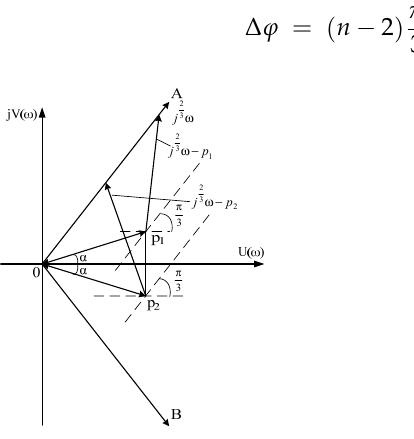
Figure 24. Vector displacement for the first two complex-conjugate roots for this case, when 𝜔 𝜖 (0, ∞)